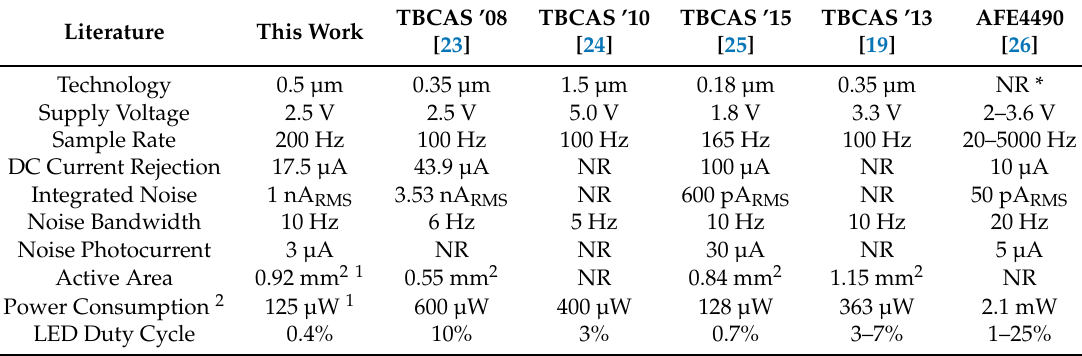
Table 1. Comparison of readout circuit performance to other integrated PPG front